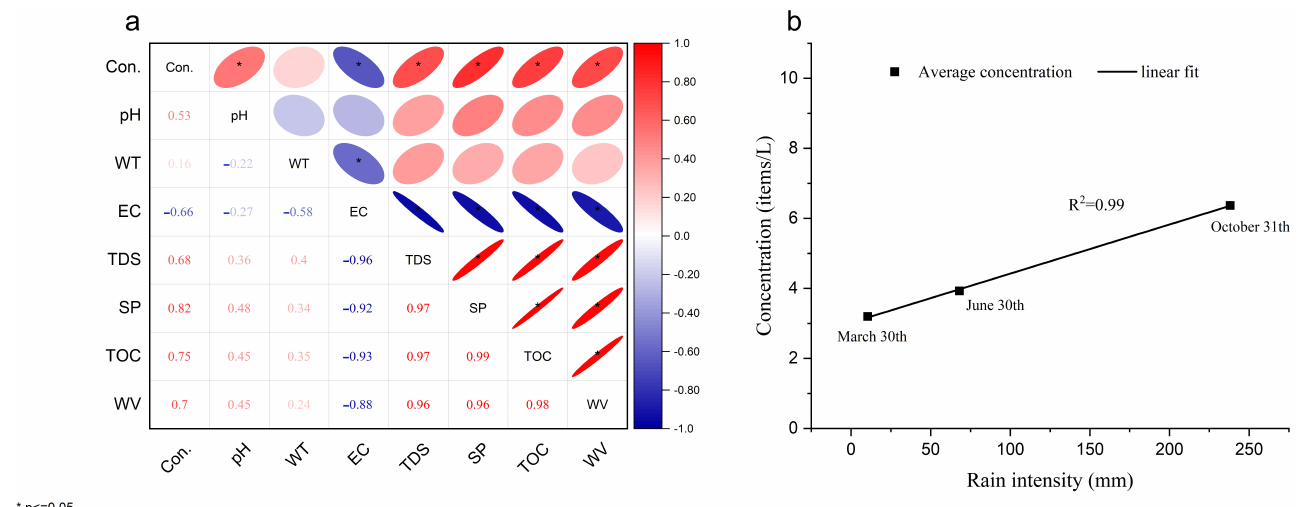
Figure 3. new fig 8. Figure 8. Relationship of microplastic abundance with water physicochemical properties and rain intensity. ( a ) water properties and ( b ) rain